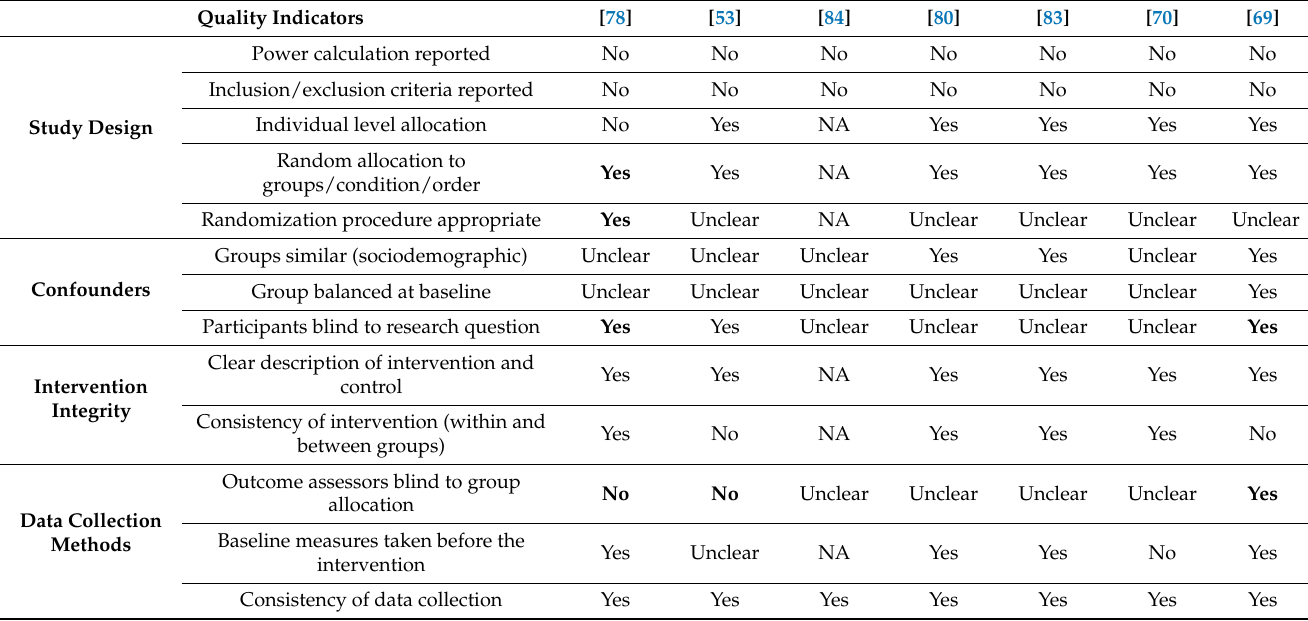
Table 5. Quality appraisal of records in this